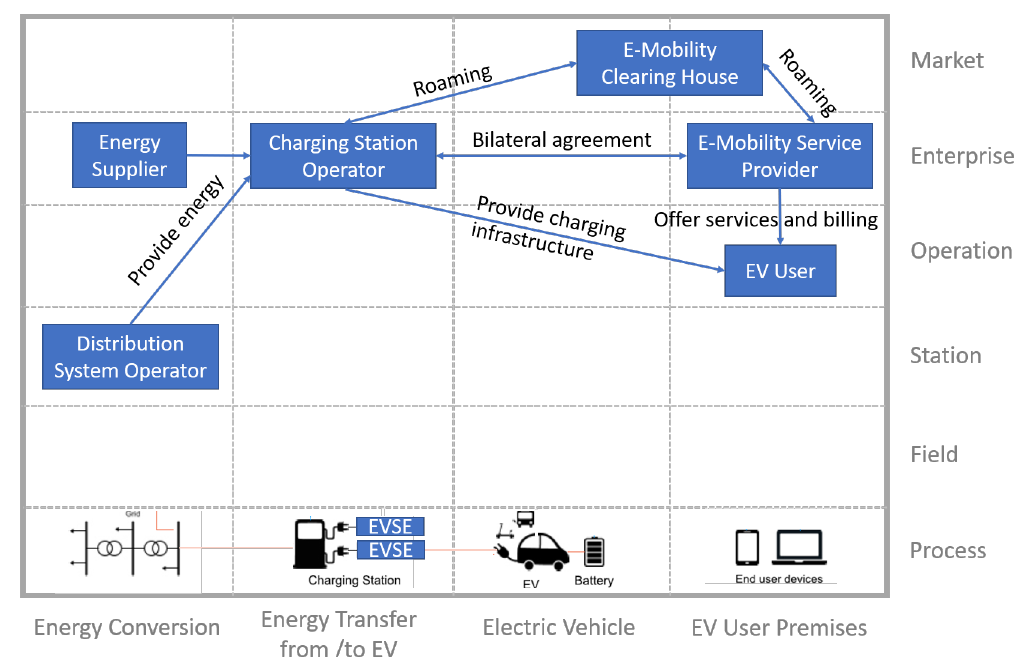
Figure 2. The most relevant sub-systems (e.g., actors/stakeholders) involved in electric mobility cyber physical system inspired by [19]. The red-coloured links demonstrate the electrical connections, whereas the blue-arrowed links illustrate the underlying role of one sub-system with respect to the other.